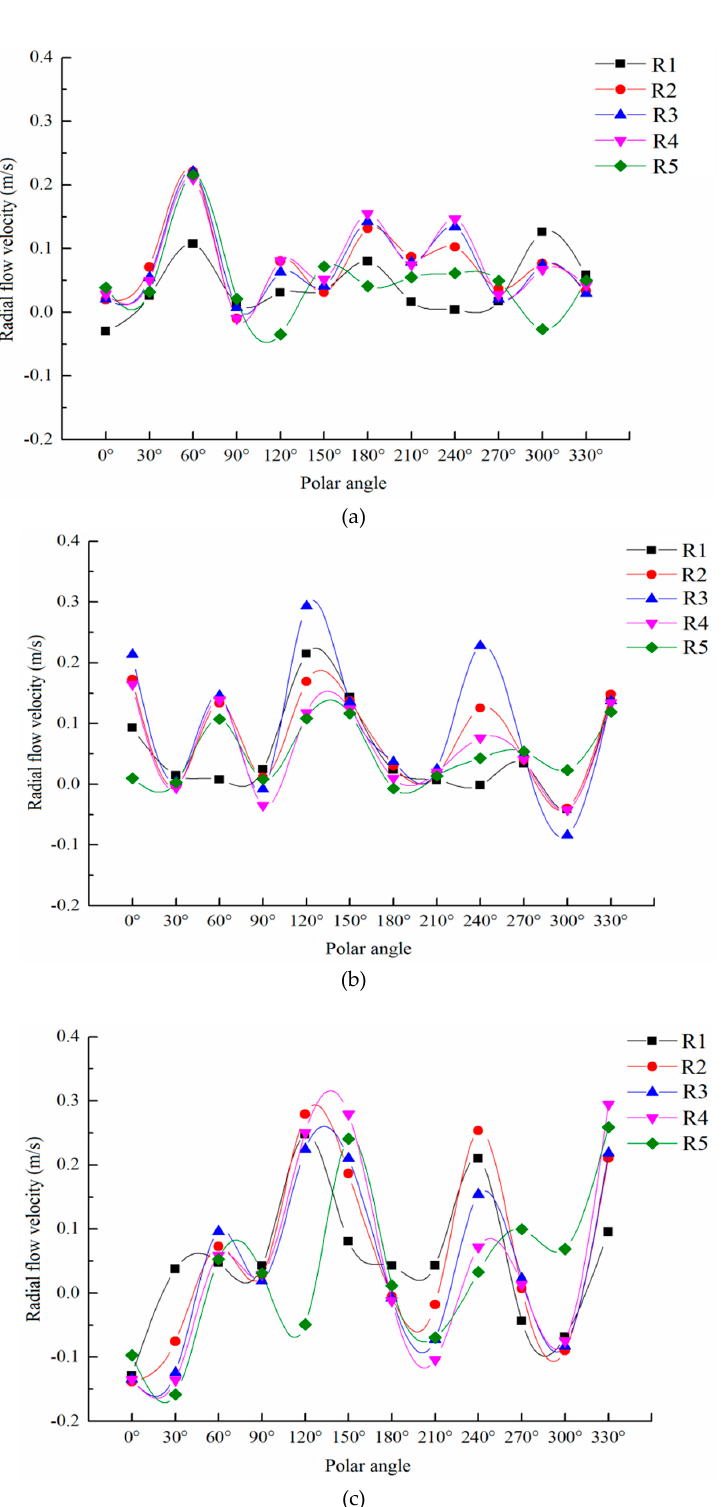
Figure 19. Radial velocity of the same measuring ring: ( a ) rear section; ( b ) middle section; and ( c ) front section. front